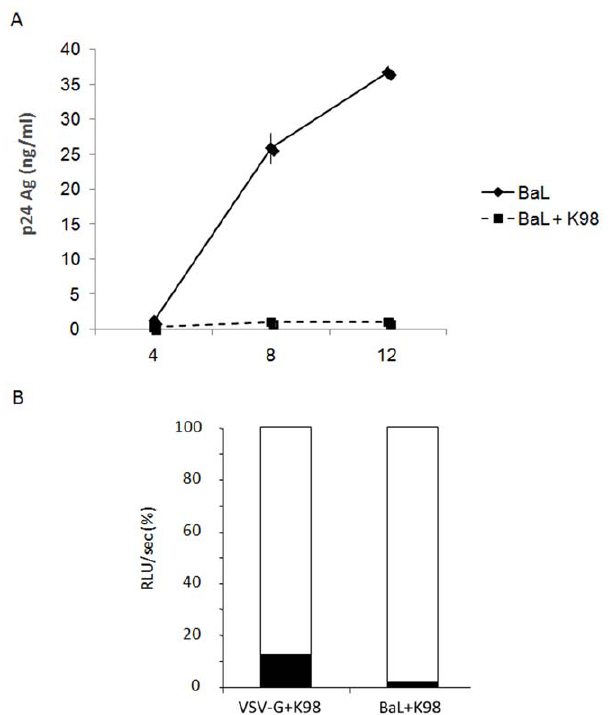
Figure 4. HIV-1 inhibition by a different T.cruzi strain. ( A ) MDM were infected simultaneously with HIV-1 BaL and K98 clone blood trypomastigotes overnight and p24 antigen production was measured in supernatants. Results are expressed as mean 6 SD of triplicates of infection and a representative experiment of 3 others is shown. ( B ) Cells were infected with BaL and VSV-G pseudotyped viruses and K98 strain blood trypomastigotes overnight. At day 4 p.i., cells were lysed and luciferase activity was measured from lysates. Results are expressed as relative light units per second (RLU/sec), presented as a percentage relative to the control (100%), where the histogram in white corresponds to the percentage of infection with the respective control virus and the histogram in black corresponds to the percentage of infection in the presence of the parasite. Results are representative of 4 independent experiments performed with cells from different donors.